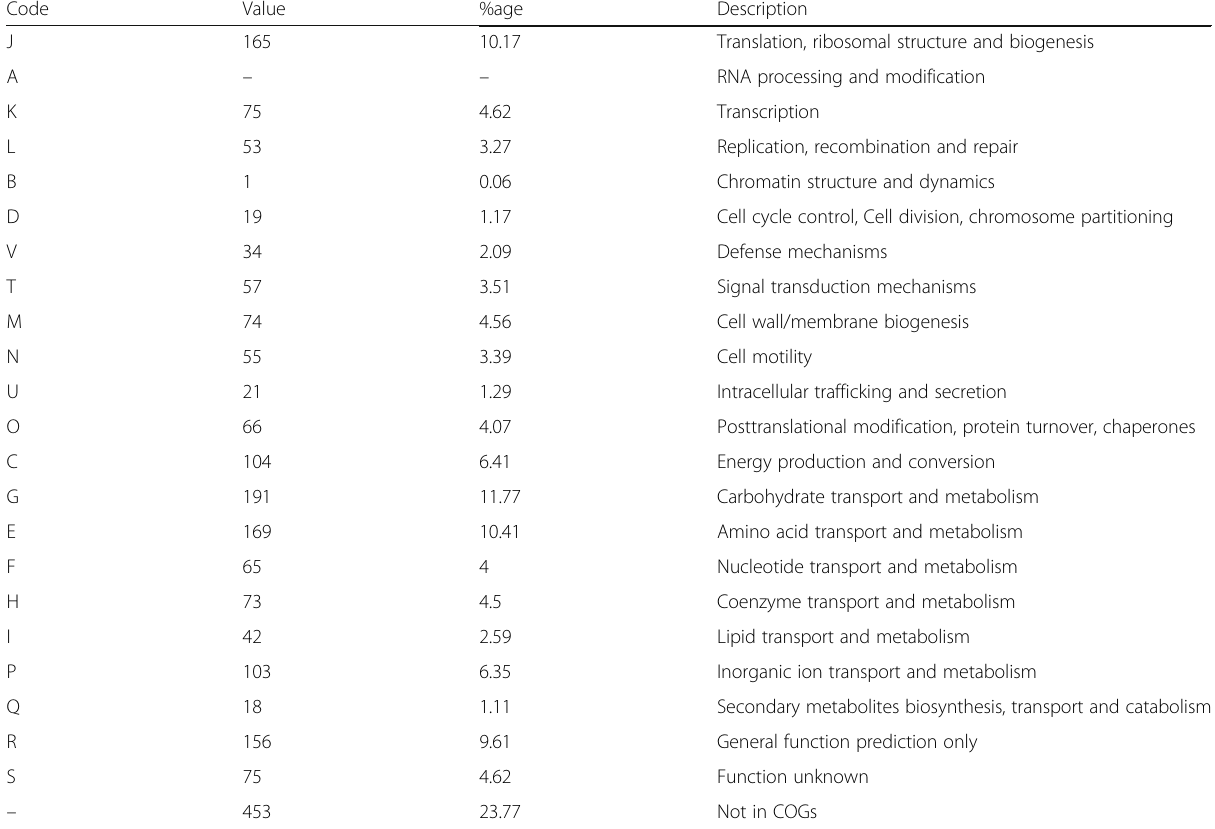
Table 5 Number of genes associated with general COG functional categories